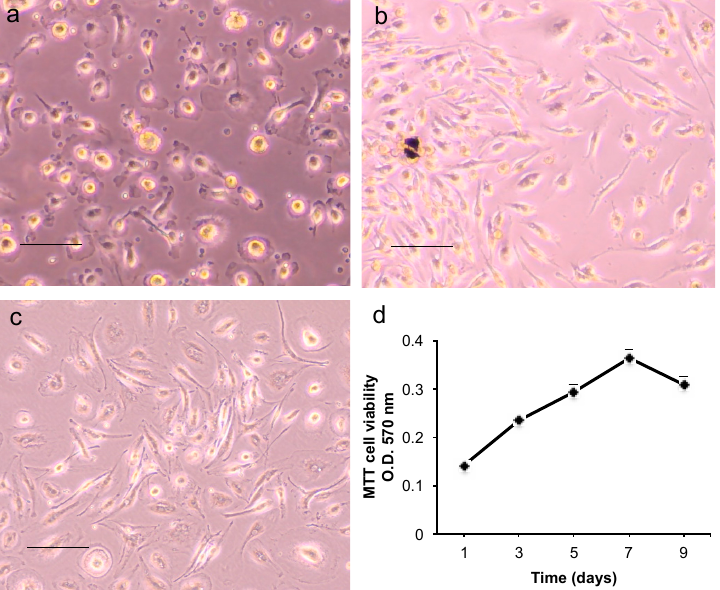
Figure 5. Morphology and cell proliferation of CGF primary cells. ( a ) Adherent cells released by the whole CGF at 14 days; ( b ) cells from CGF pieces after 14 days; ( c ) cells at third passage. Scale bar: 100 μ m. ( d ) CGF primary cell viability was assessed by MTT assay on days 1, 3, 5, 7, 9 after cell seeding. Data represent mean ± SD of duplicate measurements from three independent experiments.